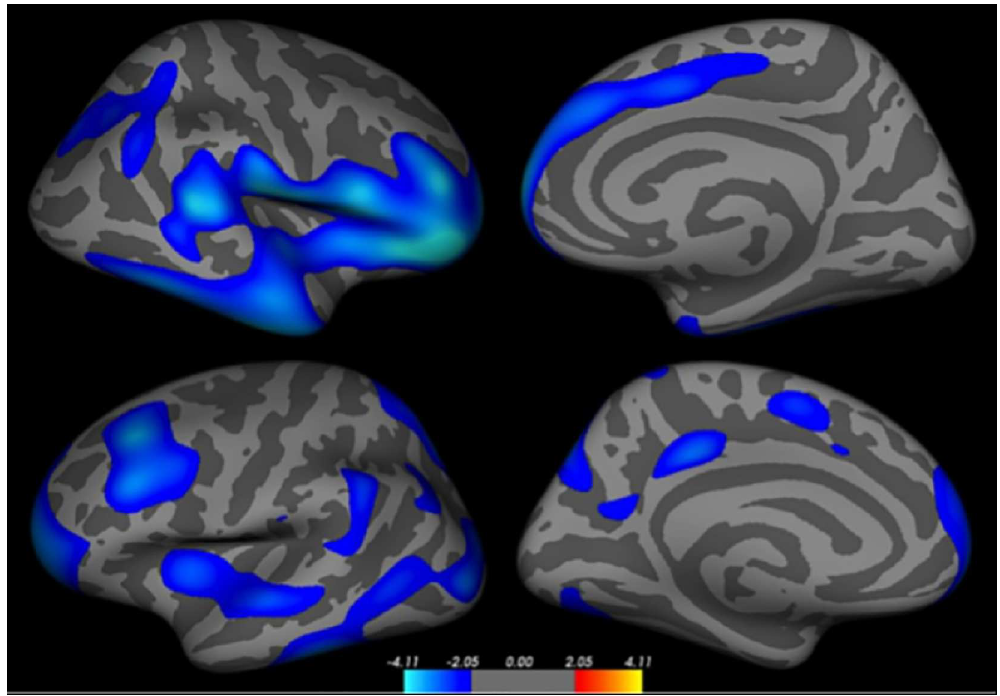
Fig 1. Cortical surface maps showing thinner cortex with log-transformed longer pain duration (right hemisphere; top, and left hemisphere; bottom). Significance at p < 0.05 FDR-corrected for multiple comparisons and controlledfor age.